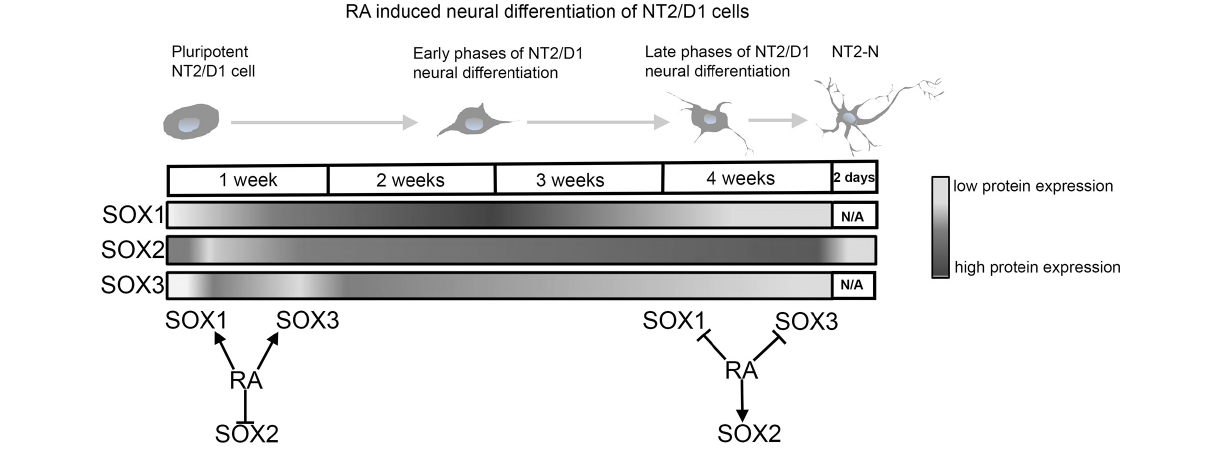
FIGURE 6 | RA modulates expression of SOXB1 proteins during neural differentiation of NT2/D1 cells. Schematic representation of SOXB1 proteins expression profiles during 4 weeks of RA induced neural differentiation of NT2/D1 cells. RA has opposite effects on SOXB1 proteins expression during early and late phases of neural differentiation of NT2/D1 cells (Stevanovic, 2003; Klajn et al., 2014; Popovic et al., 2014; Topalovic et al., 2017). N/A, not available